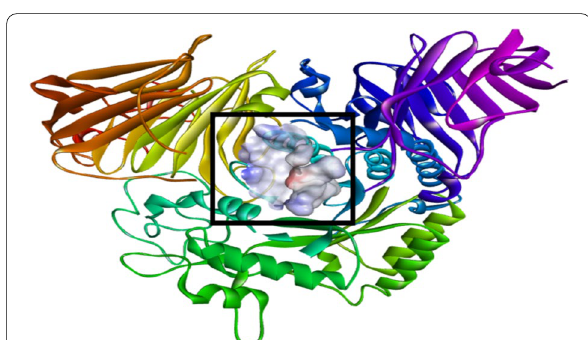
Fig. 4 Graphical representation of α -glucosidase (3L4V) indicating active site where the docking was